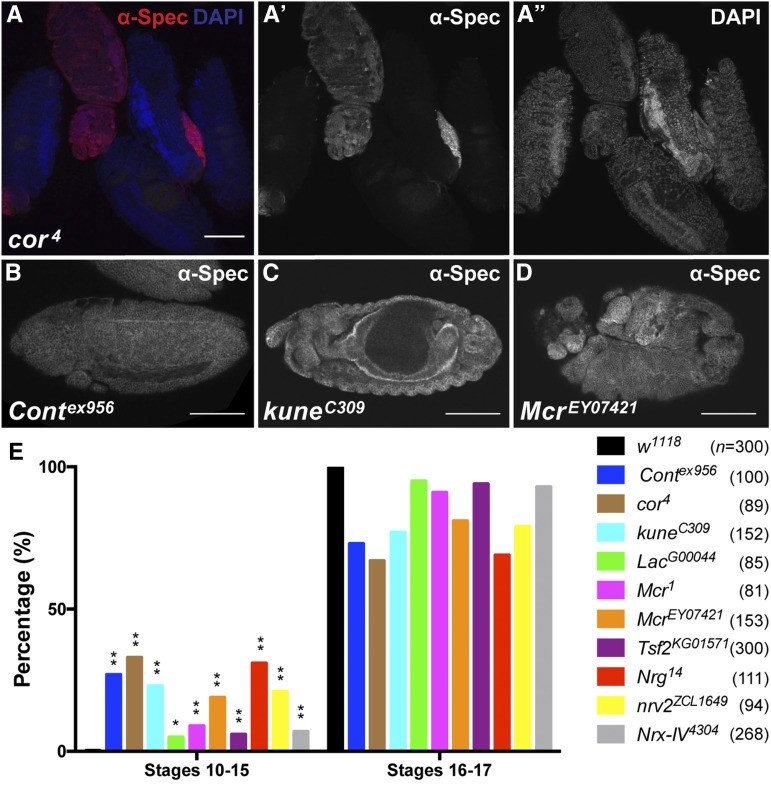
Mutations in SJ genes result in early arrested embryos. (A) Confocal optical section of a field of embryos 17–18 hr after egg laying from a self-cross of cor4/CyO, Dfd-YFP adults stained with antibodies against α-Spectrin (red and in channel A’) and with DAPI (blue and in channel A”). Note that four of the embryos have secreted cuticle and are refractory to antibody staining, whereas the second embryo from the left is a cor4 homozygous mutant (identified by absence of YFP, not shown) that has not secreted cuticle and can be stained. (B–D) Confocal optical sections of Contex956 (B), kunec309 (C), and McrEY07421 (D) mutant embryos aged 17–18 hr after egg laying and stained with antibodies against α-Spectrin to show the general morphology of the embryo. Anterior is to the left. Note that the Cont embryo has arrested prior to the initiation of germ band retraction, the kune embryo is arrested at late stage 14/early stage 15, and the Mcr mutant embryo is generally disorganized. (E) Quantitation of developmental stages of w1118 and SJ mutant embryos from a 1 hr embryo collection, subsequently aged 17 hr and then stained with antibodies against α-Spectrin. Note that all 10 SJ mutants had a significantly higher percentage of embryos arrested prior to stage 15 than the w1118 control (Fisher’s exact test). n, total numbers of embryos scored for each genotype. * P < 0.05, ** P < 0.0001. Scale bars = 100 μm.